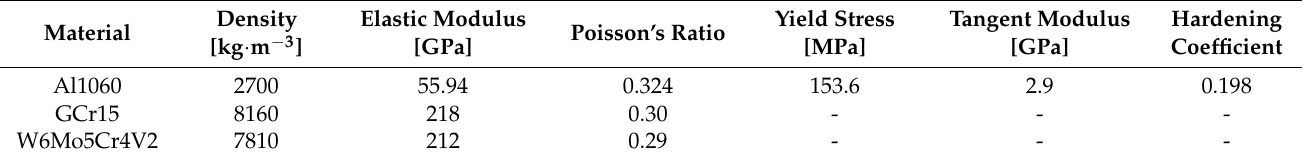
Table 1. Material mechanical property